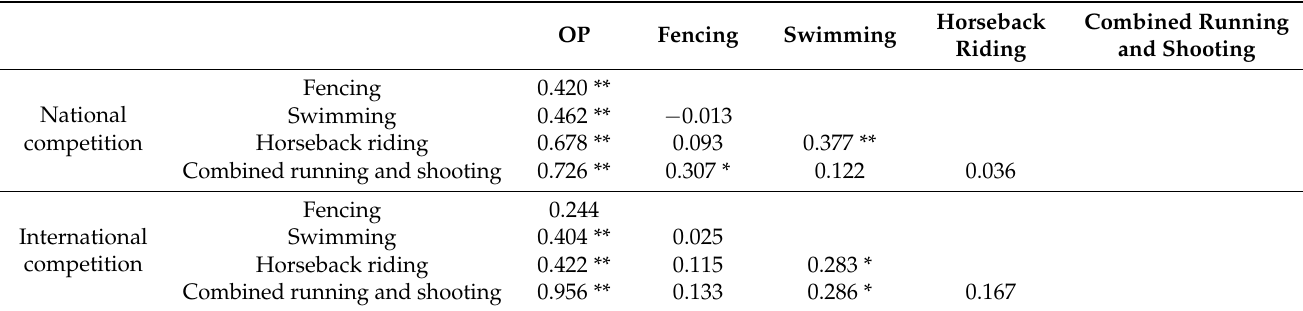
Table 1. The correlational relationships between the national and international competition and overall and selected individual events performance in modern pentathlon.